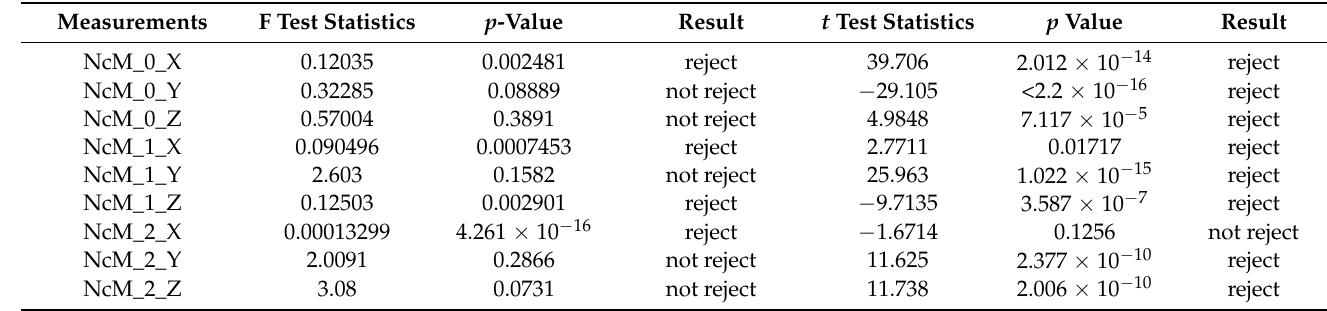
Table 10. NcM F test and t